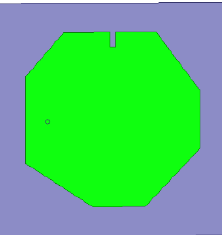
Fig. 1.12 Structure of Antenna 3 using HFSS